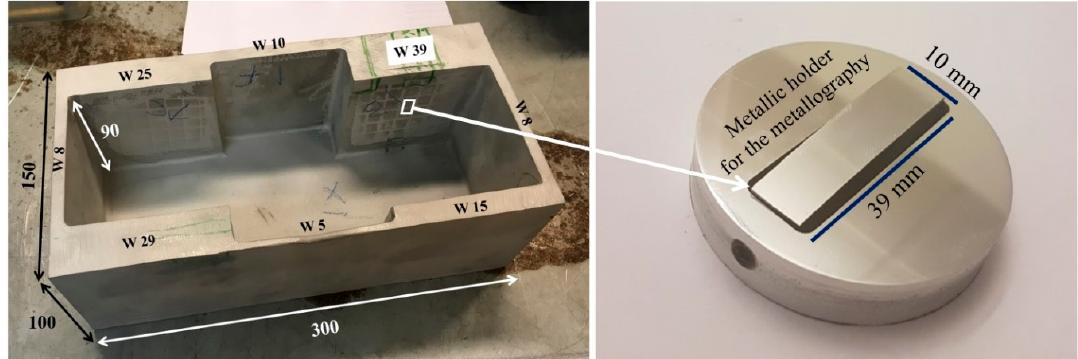
Figure 1. The A205 cast component with varied wall thicknesses (all the dimensions are provided in mm) and the typical specimen for the characterization of the microstructure.